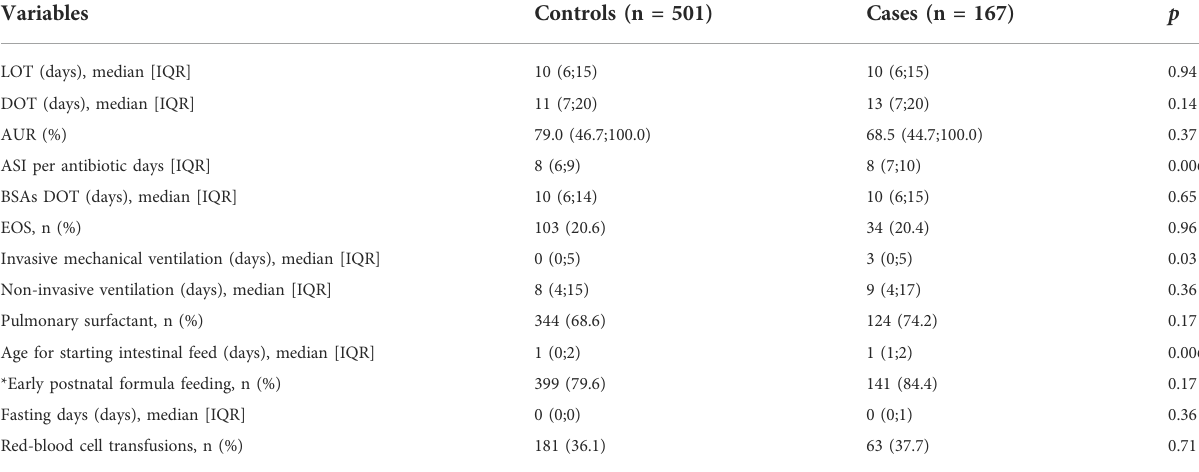
TABLE 2 Description and single factor analysis of NICU management in matched populations.